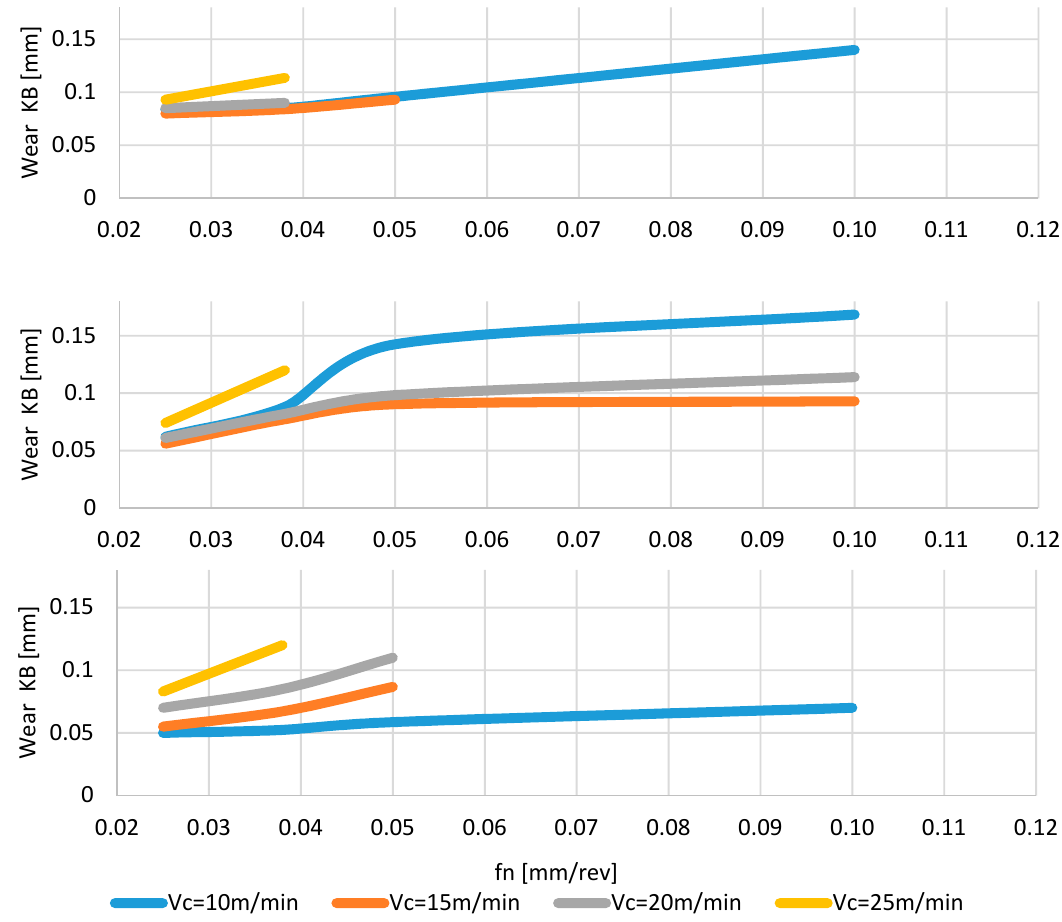
( b ) Figure 3. ( a ) Wear parameters in drilling and common locations (a. Secondary cutting edge; b. Main cutting edge, flank face; c. Main cutting edge, rake face), courtesy of Mitsubishi©; ( b ) Wear measurement on the rake face. 4. Experimental Procedure As mentioned in the above sections, three different titanium–aluminides were studied: TNB (ingot form) type and the MoCuSi types, in ingot and extruded forms. The following sections present the tool wear evolution with the associated machined volumes and machining times for a combination of cutting parameters ( v c , f n ). 4.1. Tool Wear During the tests, tool wear was inspected for each flute and then the average value was